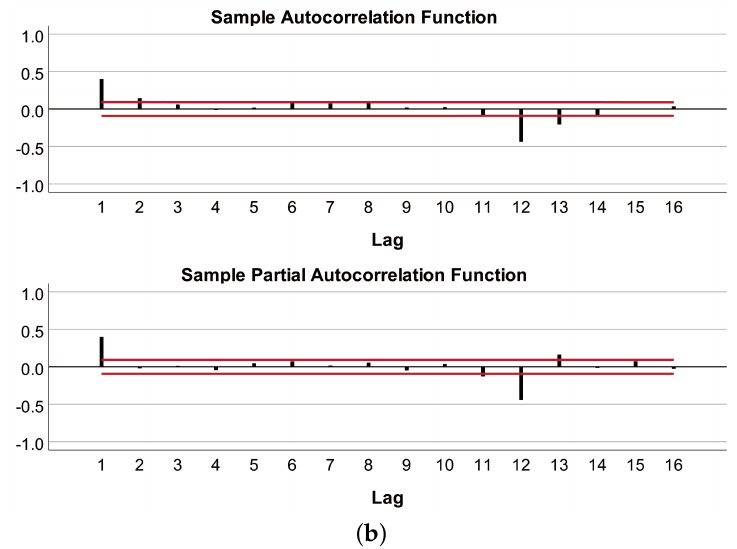
Figure 6. ( a ) the auto-correlation function (ACF) and partial auto-correlation function (PACF) diagram of the raw SSTs. ( b ) the ACF and PACF diagram of the SSTs after